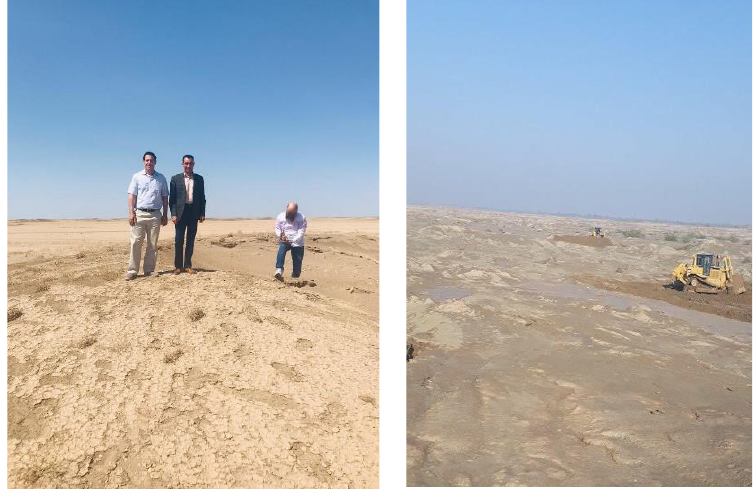
Figure 3. The hotspot area-A sediments are composed of silty sand and bare vegetation.